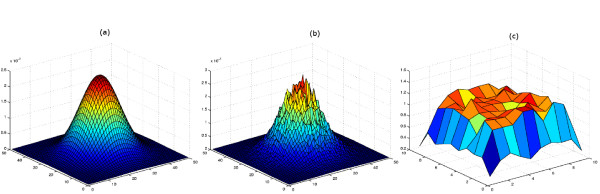
Simulated spots. Shape of (a) simulated noise free cDNA spot, (b) noisy cDNA spot, and (c) noisy single-channel oligonucleotide array spot. Intensity of the spot is determined by the corresponding expression value.